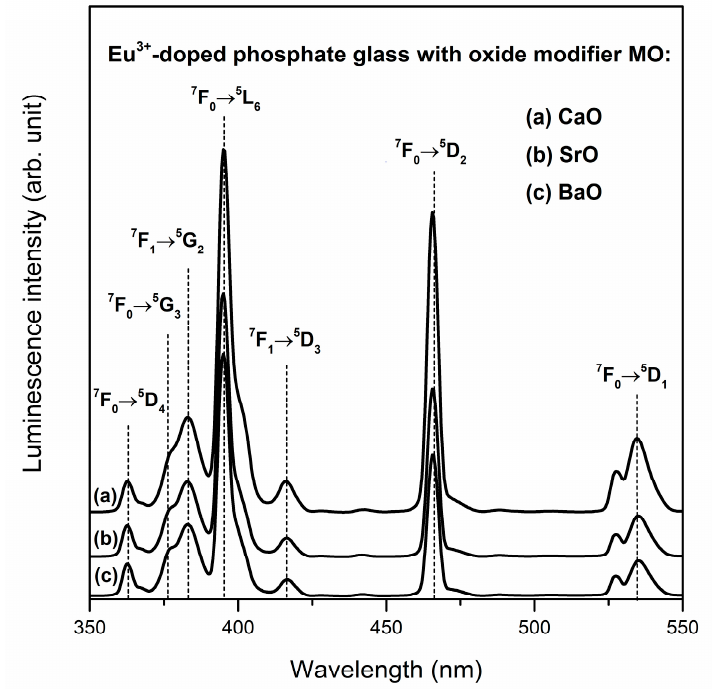
Figure 7. Excitation spectra for Eu 3+ -doped phosphate glasses with oxide glass modifiers MO.